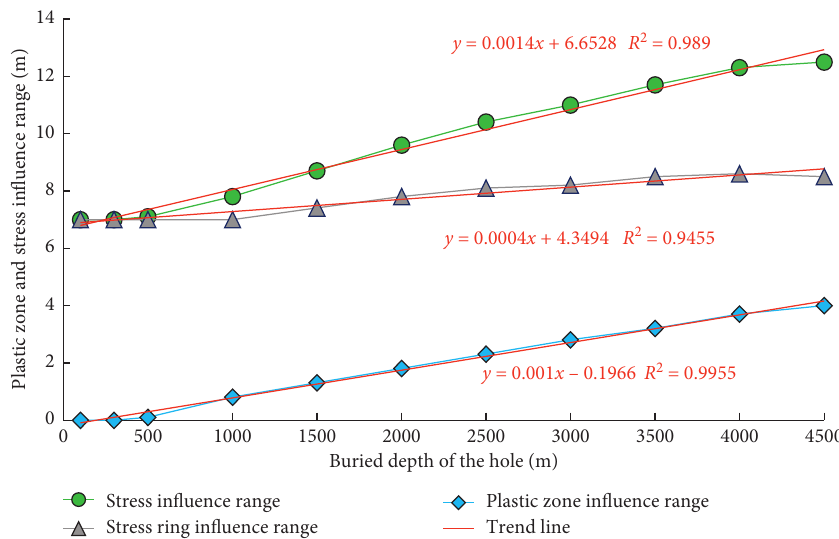
Figure 8: Relationship between the plastic area range of holes and the influence range of stress under mudstone conditions.